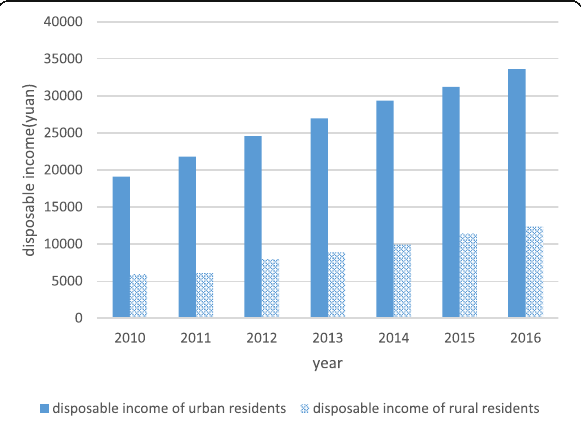
Fig. 2 Disposable income of urban and rural